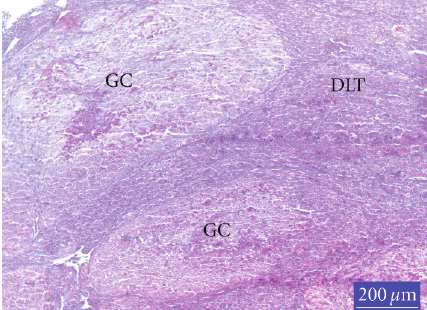
Figure 2: Section from the SR of rabbits from AF-treated group, GC: germinal center, DLT: di ff use lymphoid tissue; lymphoid cell depletion in GC is clear, trichrome